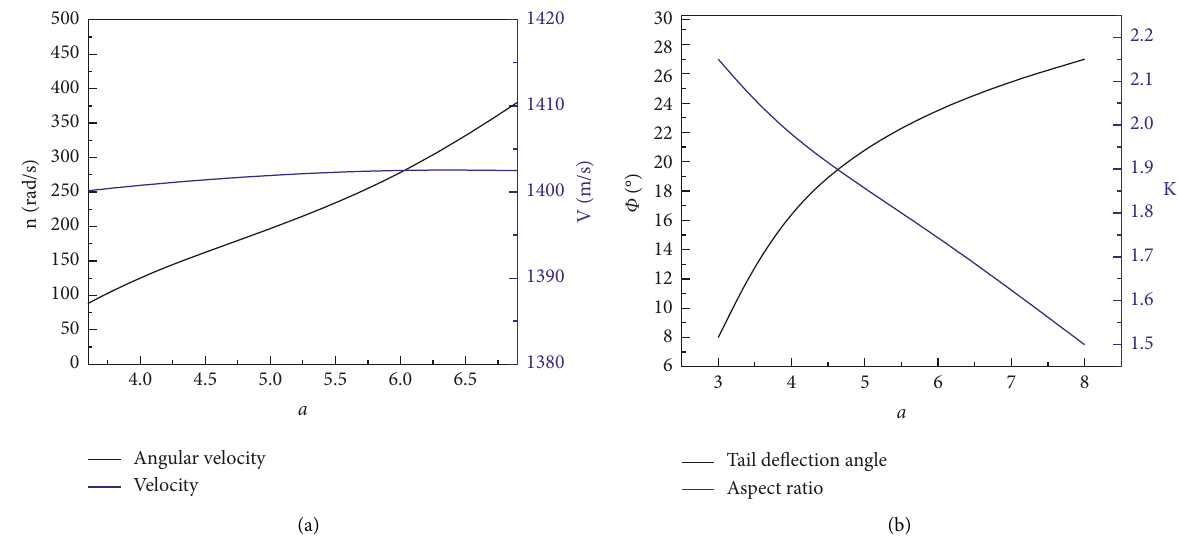
Figure 21: Variations of the angular velocity, axial velocity, tail fin tilt angle, and aspect ratio with the number of steps. (a) Variations of the angular and axial velocities with the number of steps. (b) Variations of the tail fin tilt angle and the aspect ratio with the number of